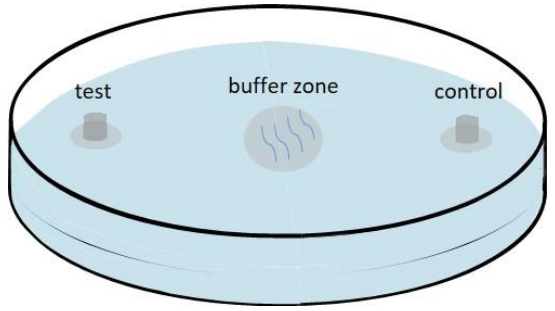
Figure 7. Schematic diagram of the attraction assay.